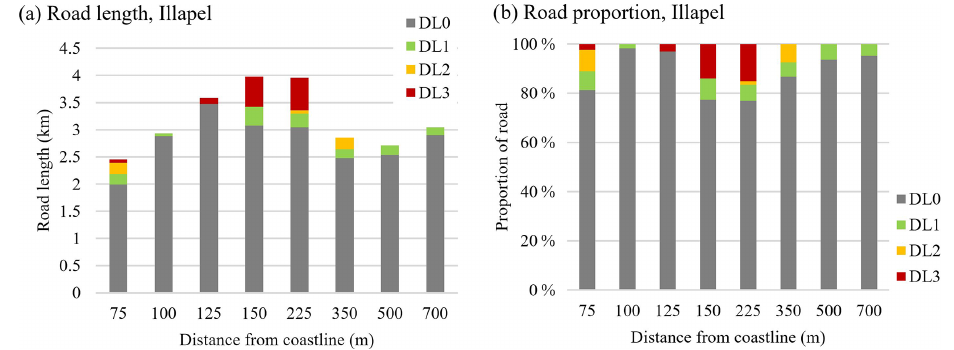
Figure 8. Total length (a) and proportion (b) of exposed roads, by distance from the coastline (as a proxy for inundation energy), for the 2015 Illapel earthquake and